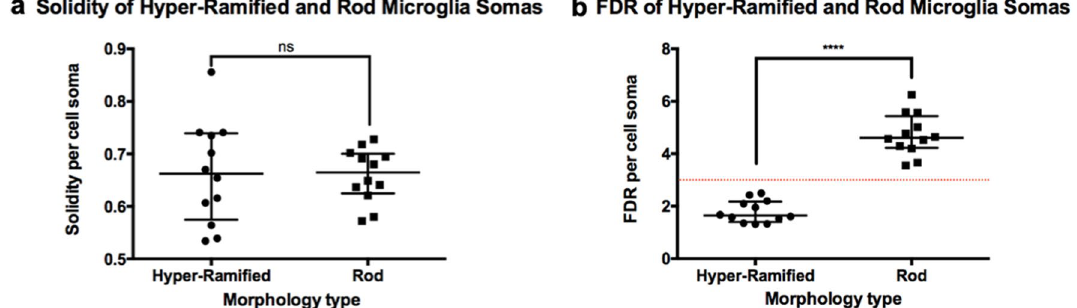
Figure 3. Cell solidity and FDR: Hyper-ramified and Rod microglia. Graphs showing no significant difference in solidity between hyper-ramified and rod microglia ( a ) whilst there was a significant difference in FDR ( b ) (****p < 0.0001, two-tailed Mann–Whitney